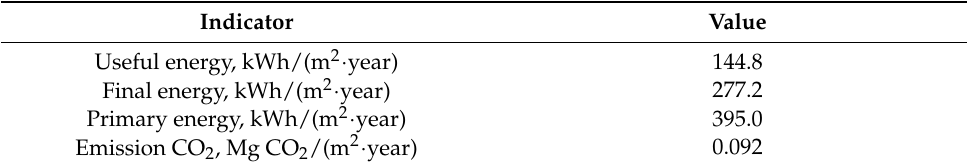
Table 5. Energy performance indicators—variant 0.